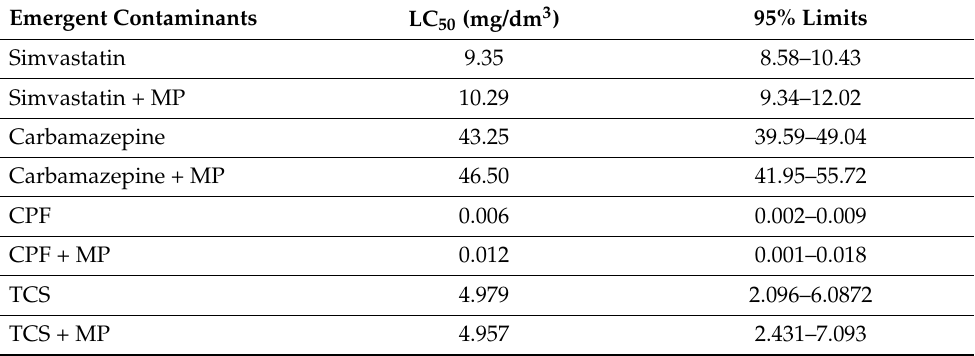
Table 2. Forty-eight-hour LC 50 values and confidence intervals for adult A. salina exposed to different toxicants (simvastatin, simvastatin + MP, carbamazepine, carbamazepine + MP, CPF, CPF + MP, TCS and TCS + MP).